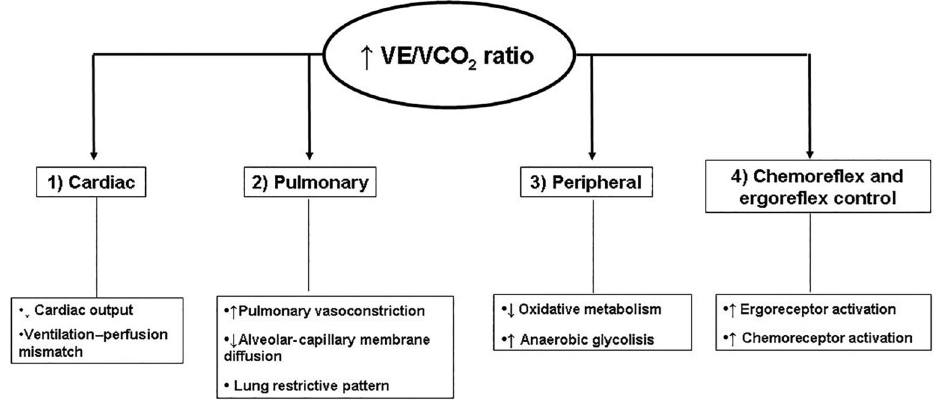
Figure 4. Potential mechanisms suggested for reduced ventilatory ef fi ciency (increased ventilation to carbon dioxide production relationship (VE/VCO 2 ) in cardiac